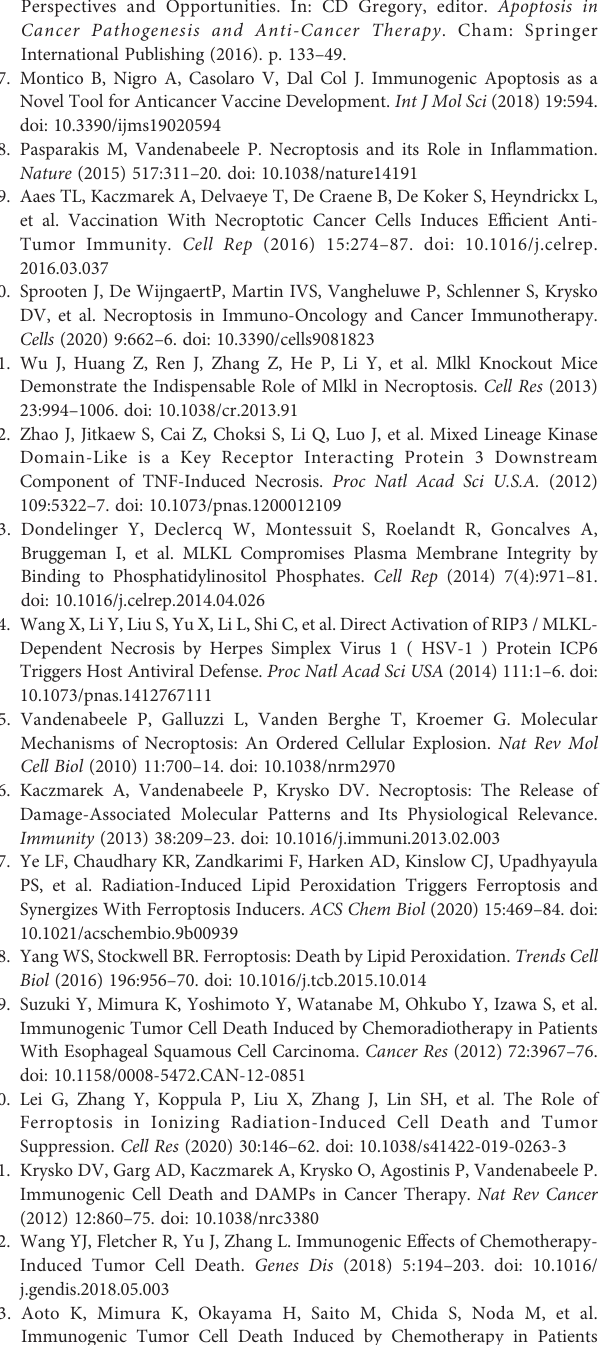
Supplementary Table 2 | Association between cell death markers, DAMPs, Age, FIGO, Lymph-node statuswithRelapse orCSS. Association between the cell death